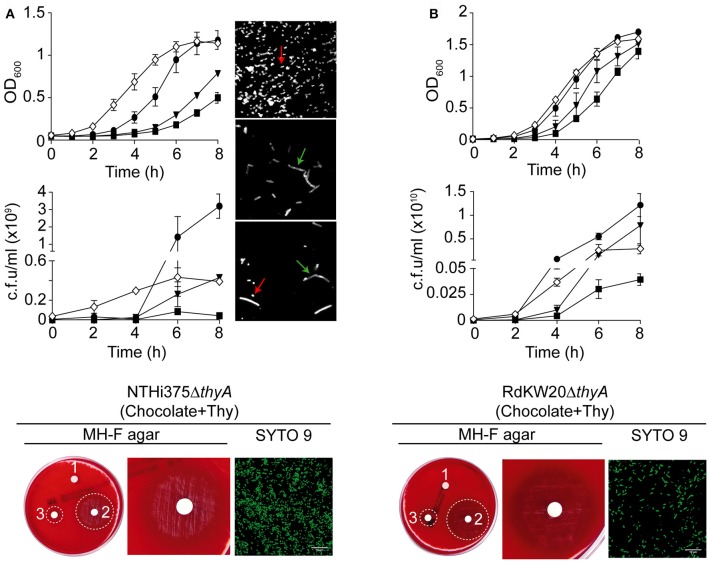
H. influenzae growth is modified by thymidine availability. Bacterial growth, in the absence or presence of supplemented thymidine is shown for NTHi375 (A) and RdKW20 (B) WT and ΔthyA strains. Growth in sBHI is shown as a means of OD600 (upper) and c.f.u./ml (middle) at the indicated time points. WT strains were grown in sBHI (black circle); ΔthyA strains were (i) grown in sBHI (black square), (ii) grown in sBHI+thymidine 300 μg/ml (inverted black triangle), (iii) pre-grown in sBHI+thymidine 300 μg/ml and further diluted in sBHI for growth recording (white diamond). (A,B) bottom: growth of ΔthyA mutants, pre-grown on chocolate agar with thymidine 300 μg/ml (chocolate+Thy) and inoculated on MH-F agar with sterile discs soaked in water (1), thymidine 10 mg/ml (2), thymidine 300 μg/ml (3). Dotted circles indicate the growth zone around discs; bacterial morphology is shown by SYTO 9 staining and confocal microscopy (scale bar, 10 μm). Immunofluorescence microscopy at the final time point of the growth curve is shown for NTHi375 WT, ΔthyA, and ΔthyA pre-grown in sBHI supplemented with thymidine 300 μg/ml (top, middle, and bottom images in A, right, respectively). Red arrows indicate the average NTHi WT size; green arrows indicate non-septated bacterial filaments. Bacteria were labeled with rabbit anti-NTHi primary—and a donkey anti-rabbit conjugated to Cy2 secondary antibodies.